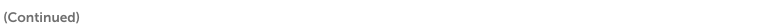
FIGURE4(Continued) WT rats. n = 6 per group, Scheffé multiple-comparison test; * p < 0.05, ** p < 0.01, *** p < 0.001. Data are presented as mean ± SEM . (B) Comparison of seizure latency, seizure duration, and seizure score between BTN-treated and NS-treated Scn1a + / − rats at P21. BTN significantly increased seizure latency of Scn1a + / − rats at P21. n = 6 per group, Mann–Whitney U test; * p < 0.05. Data are presented as mean ± SEM. BTN, bumetanide; NS, normal saline; P, postnatal day; M1, primary motor cortex; CI, confidence interval; M2, secondary motor cortex; CPu, caudate-putamen (striatum);